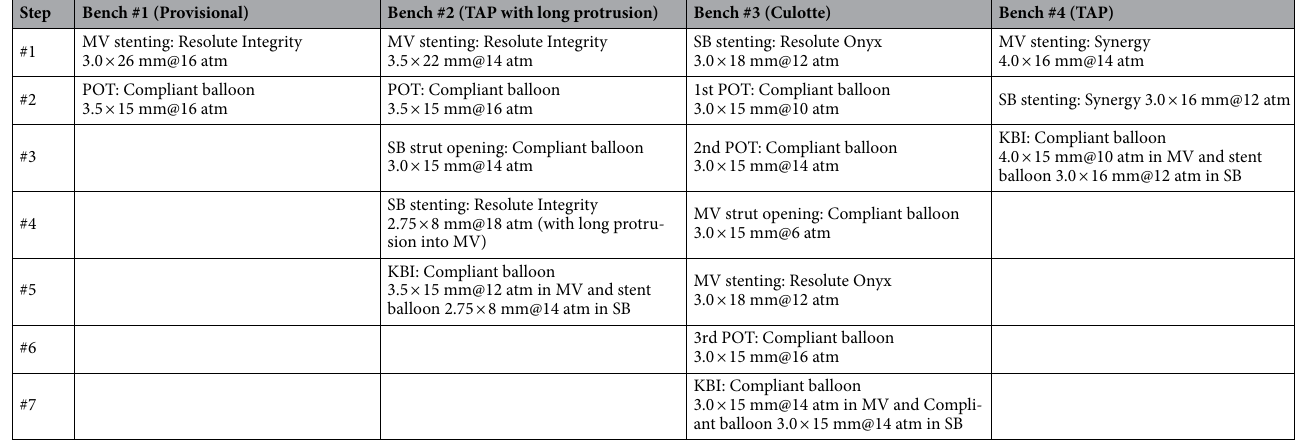
Table 1. Stenting techniques and procedural steps in bench cases. MV main vessel, SB side branch, POT proximal optimization technique, KBI kissing balloon inflation, TAP T-and Protrusion technique, atm atmosphere.